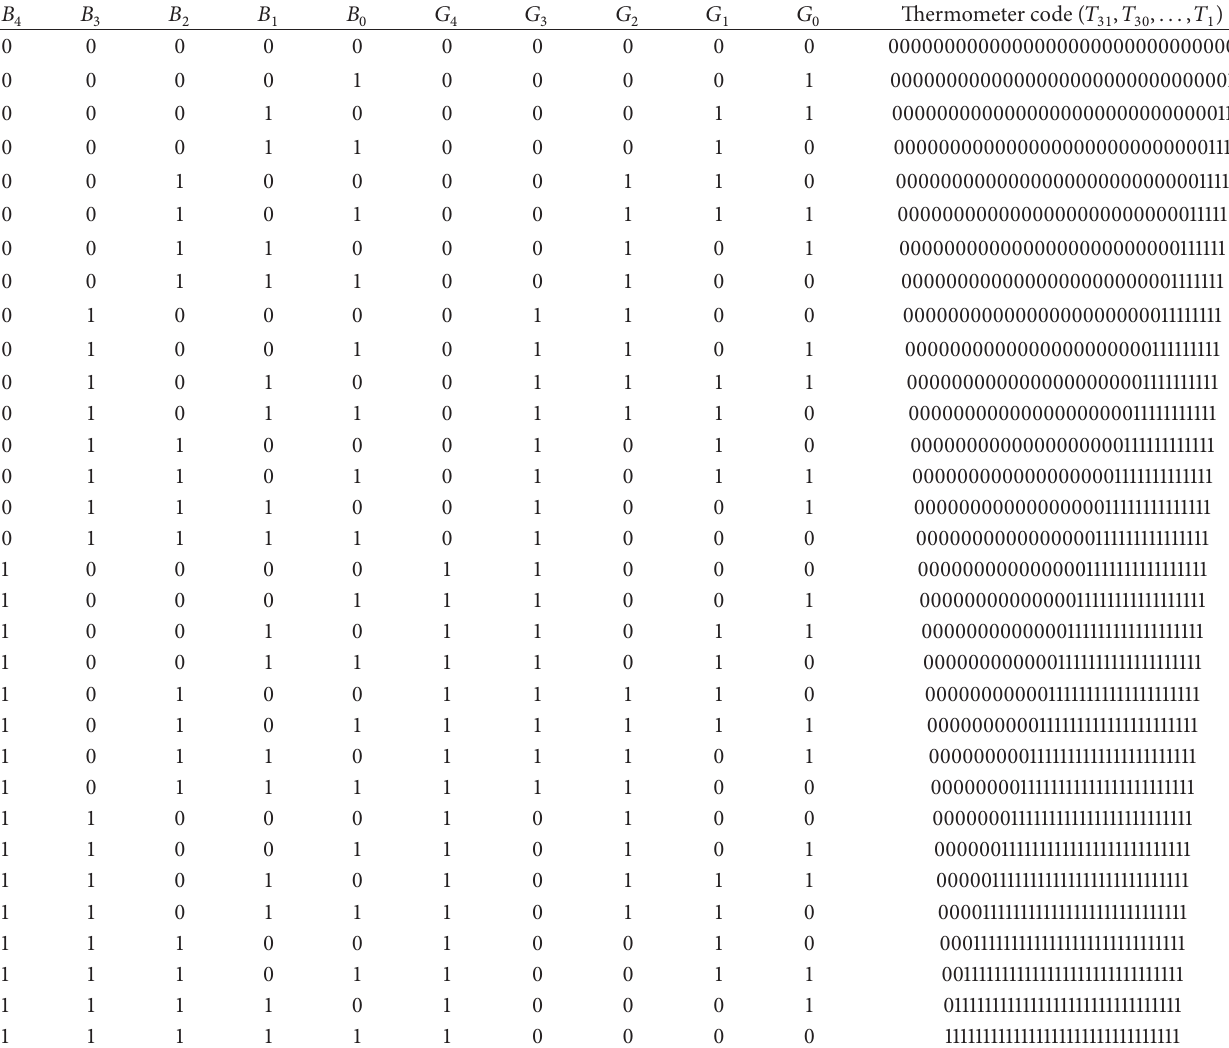
Table 2: Binary to gray code encoder truth